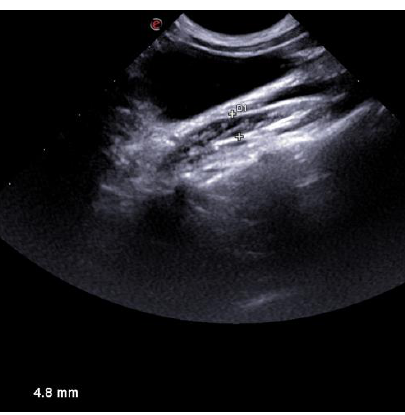
Figure 6. Sample of the fluid drained from the uterus.